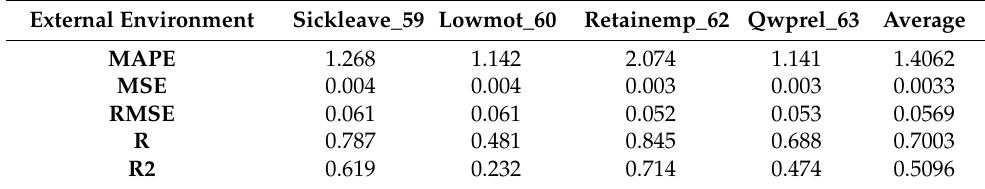
Table 13. Testing results for the effect of the external environment on employee